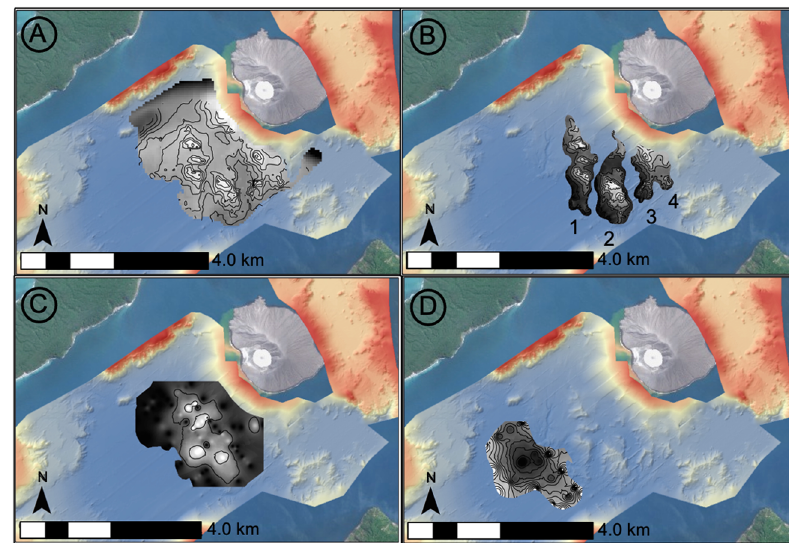
Fig. 9 Landslide volumetric distributions. A Difference map between 1990 bathymetry and new 2019 bathymetry over the landslide area; B Isolated difference maps of the four numbered landslide block trains (combined block trains 3 and 4); C Interpolated depth of erosion beneath the landslide block area based upon new 2019 seismic re fl ection pro fi les; and D Interpolated thickness of the buried debris fl ow beyond the proximal landslide blocks based upon new 2019 seismic re fl ection pro fi